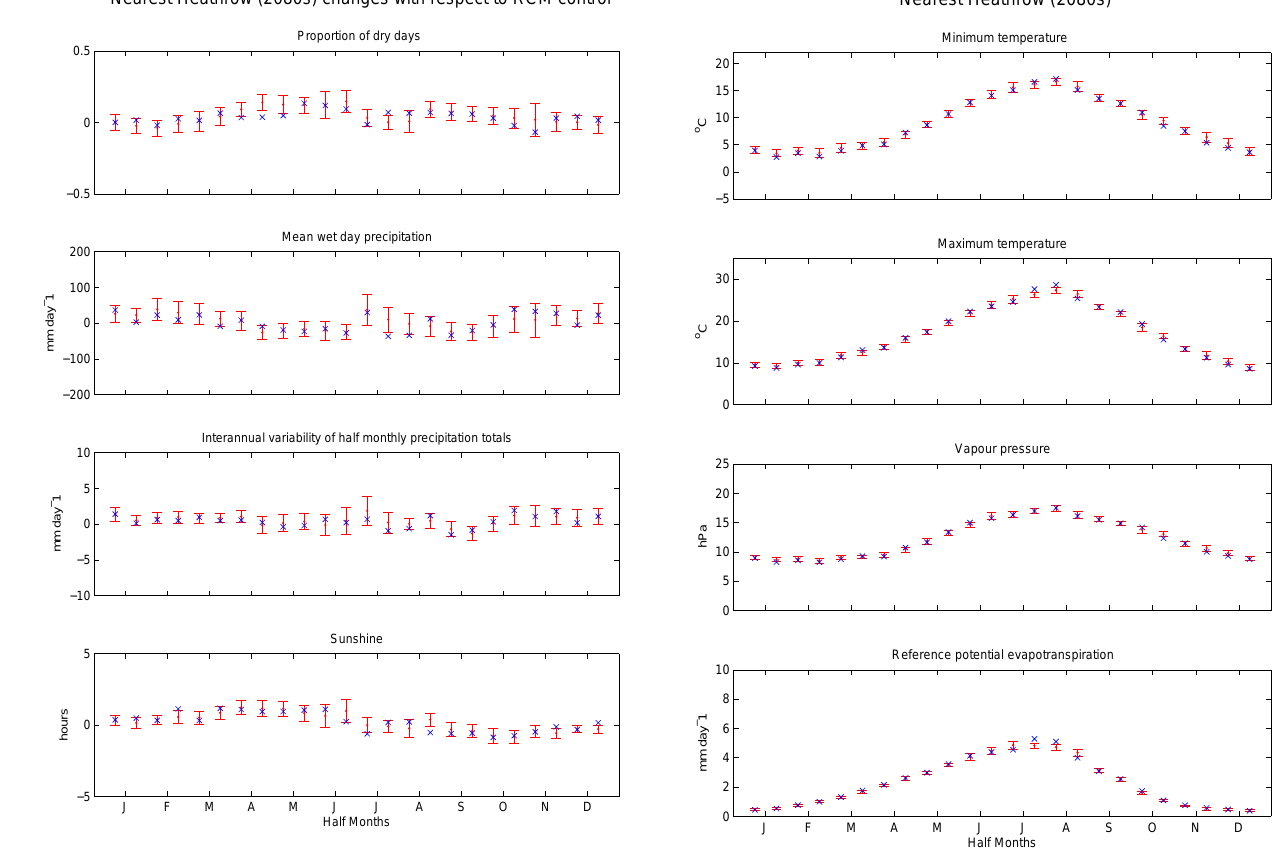
Fig. 3c. RCM 2080s scenario (HadRM3Q0 – blue, shown as crosses) and simulated (red dots and error bars) averages for each half month for the grid cell nearest Heathrow based on a 30yr period (1961–1990). The simulated values are the means of 100 weather generator runs. The lines and bars show the variability of the 100 runs (plotted as plus/minus two standard deviations around the